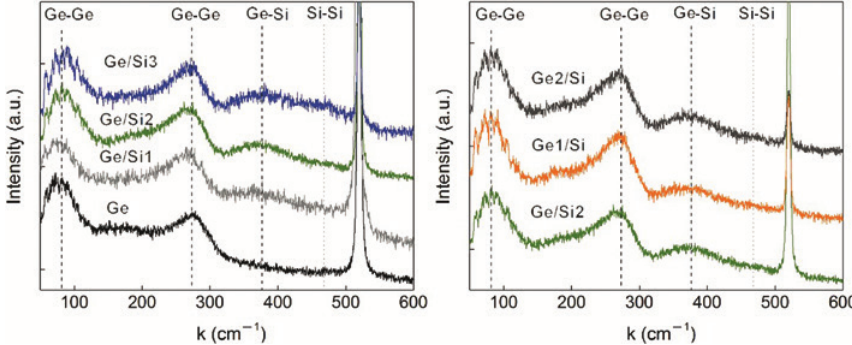
Figure 5: Raman spectrum of Ge, Ge/Si1, Ge/Si2, and Ge/Si3 and Ge1/Si, Ge2/Si, and Ge3/Si